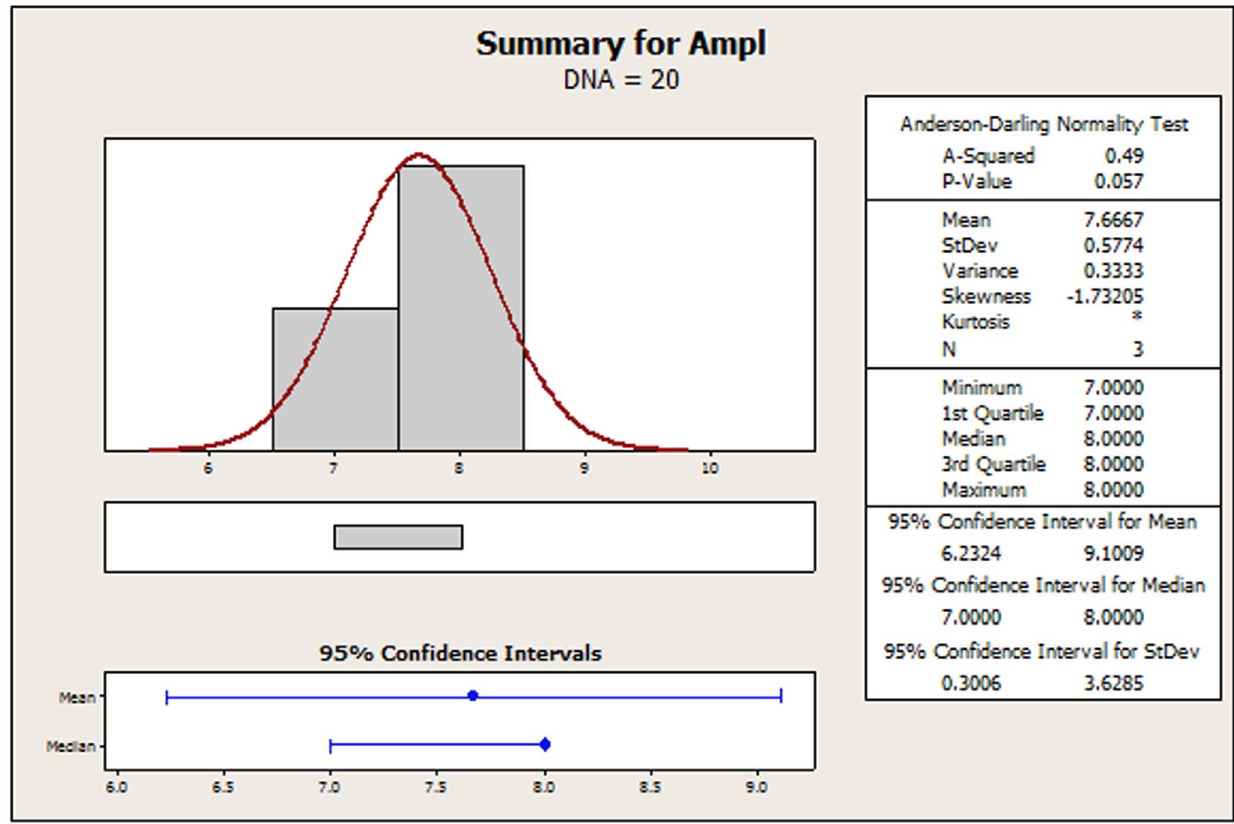
Table 1. Skewness of the amplicon OA-data for the AP-PCR study.